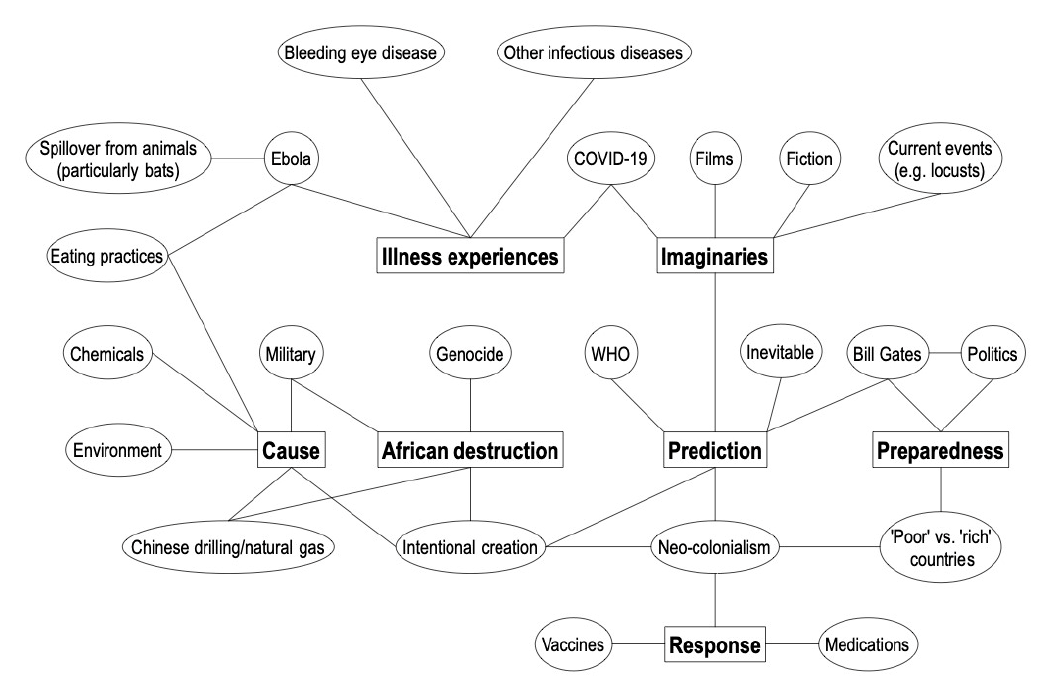
Figure 1. Narrative themes and sub-themes. Image by Nitin